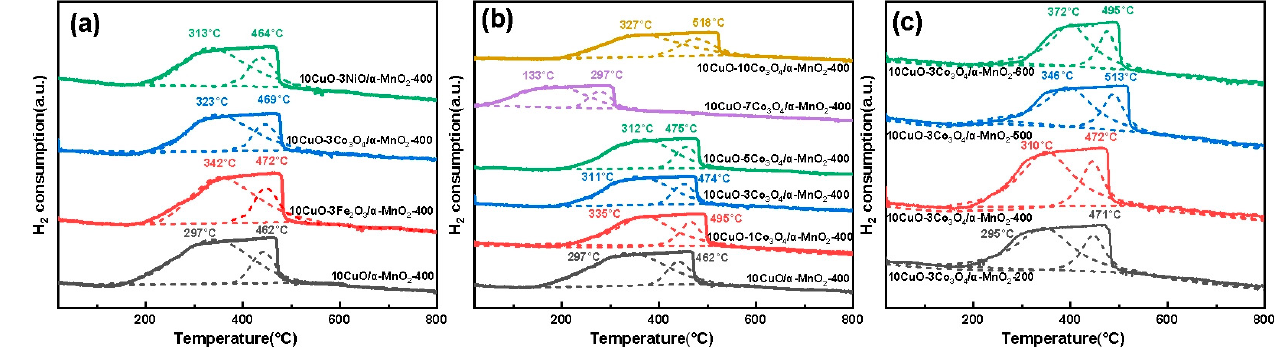
Figure 6. H 2 -TPR profiles of the ( a ) 10CuO-3MOx/ α -MnO 2 -400 (MOx = Fe 2 O 3 , Co 3 O 4 , NiO), ( b ) 10CuO-yCo 3 O 4 / α -MnO 2 -400 (y = 0, 1, 3, 5, 7, 10), and ( c ) 10CuO-3Co 3 O 4 / α -MnO 2 -T (T = 200, 400, 500, 600 °C) catalysts.